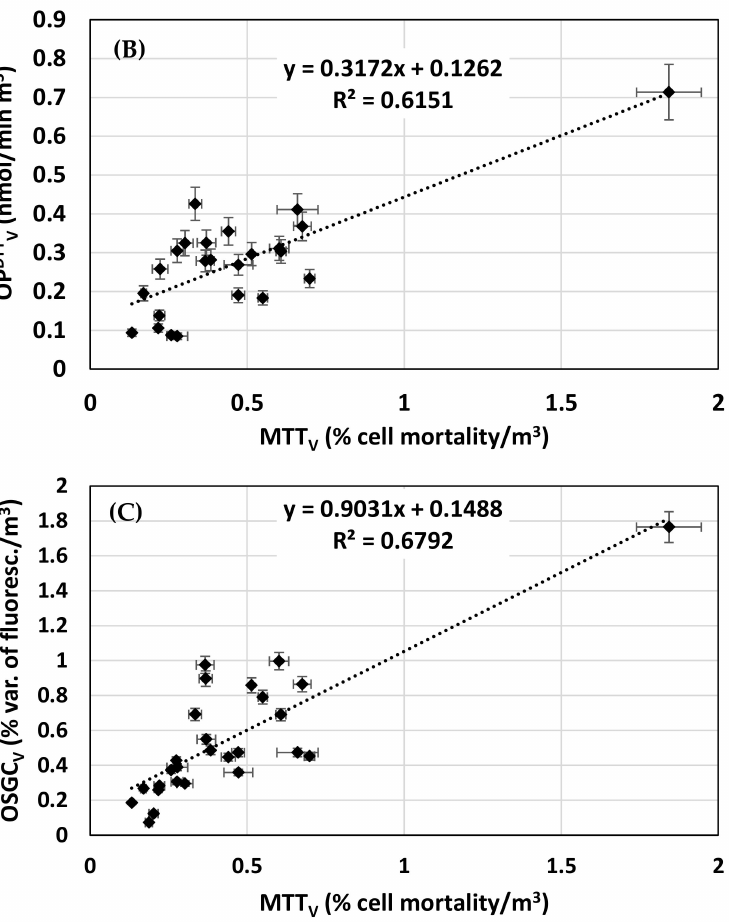
Figure 5. Relationship between the outcomes of volume-normalized OP, cytotoxicity, and oxidative stress-inducing capacity of PM 10